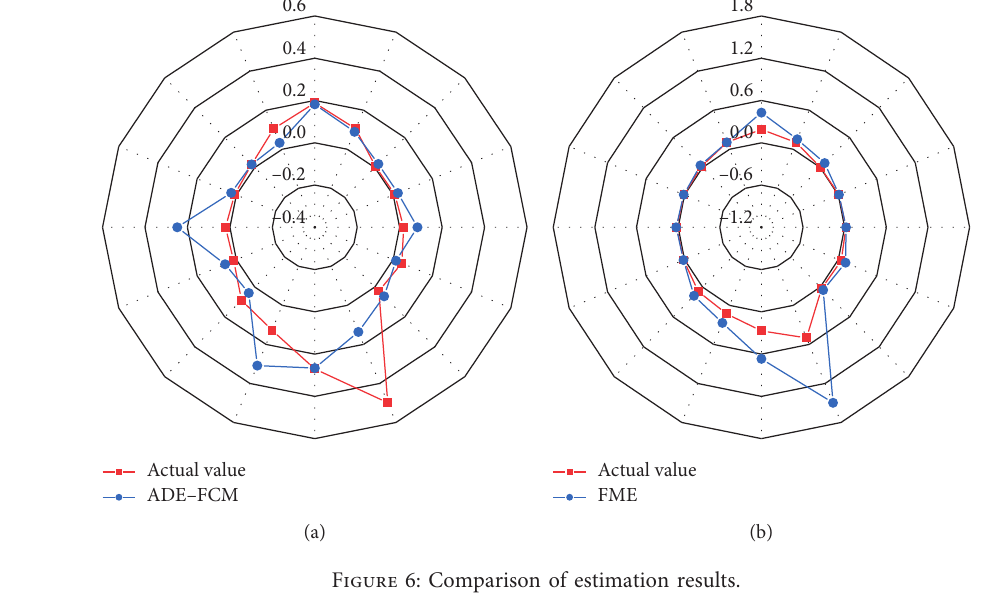
Figure 6: Comparison of estimation